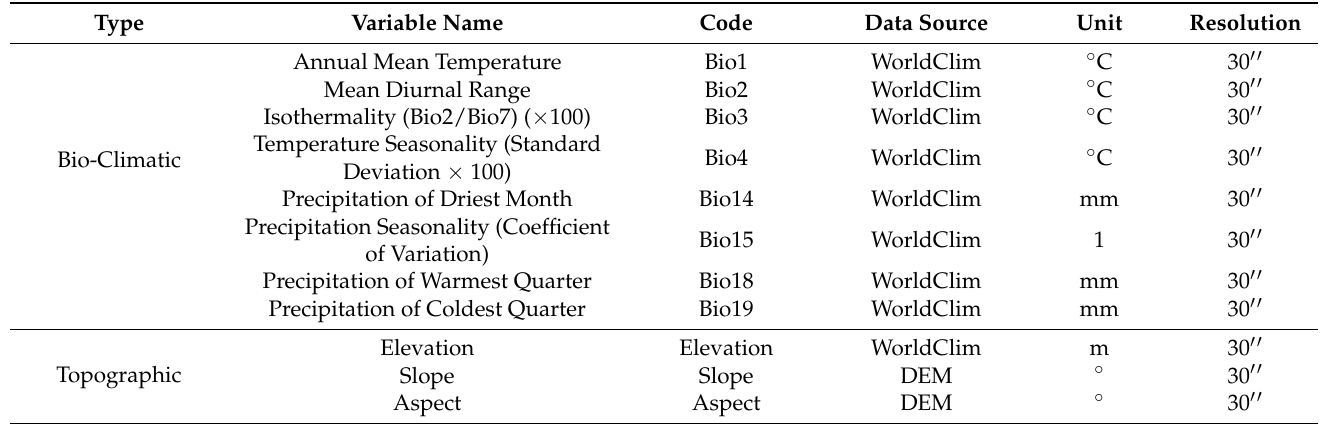
Table 1. Environmental variables for modelling the habitat suitability for Meconopsis species and four typical species.